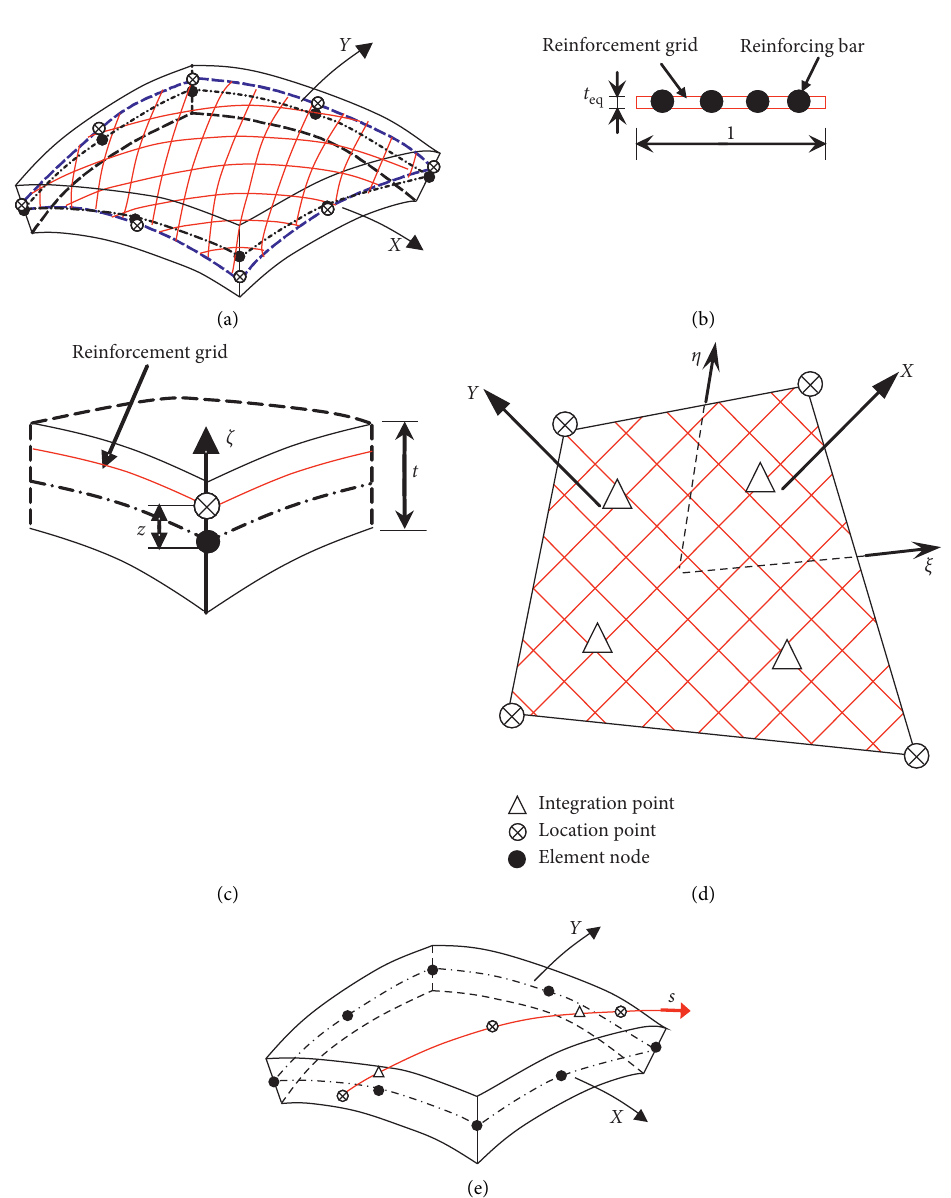
Figure 13: Composite degenerated shell element [22]: (a) composite shell element, (b) modeling of reinforcing bars via reinforcement grid, (c) location of reinforcement grid in the shell element, (d) segment of reinforcement, and (e) autogeneration of the